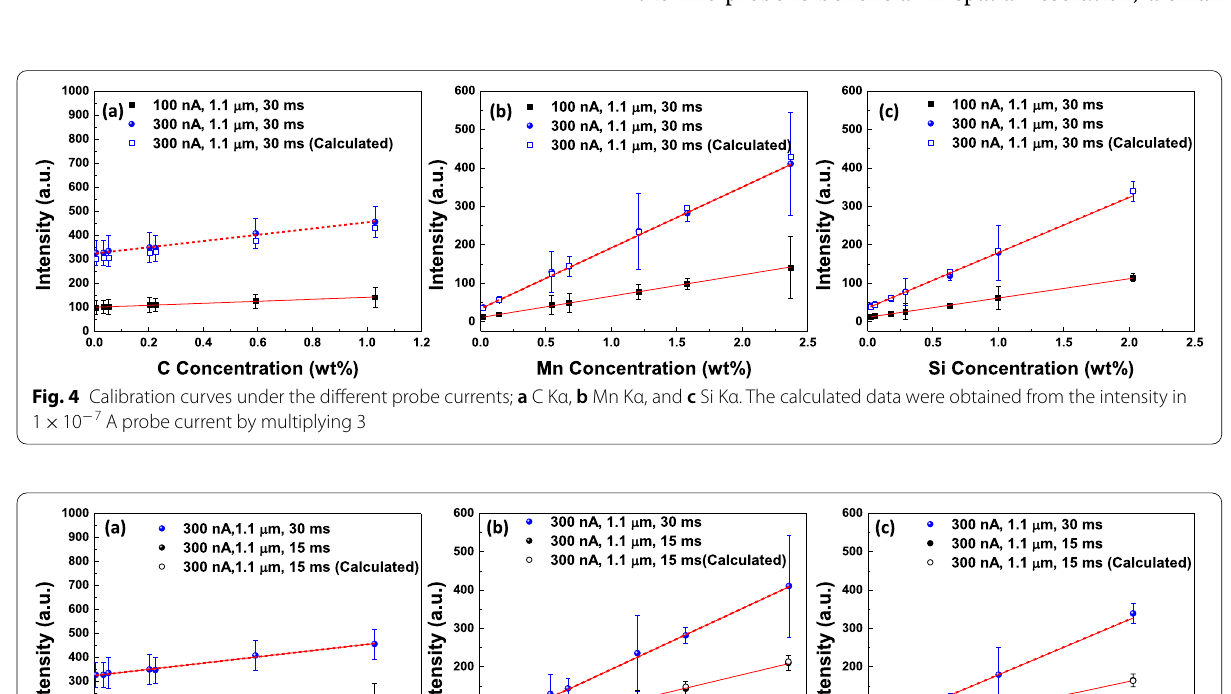
10 − 7 A, 1.1 μm (beam diameter), and 30 ms (dwell time); a C Kα, b Mn Kα, and c Si Kα ×